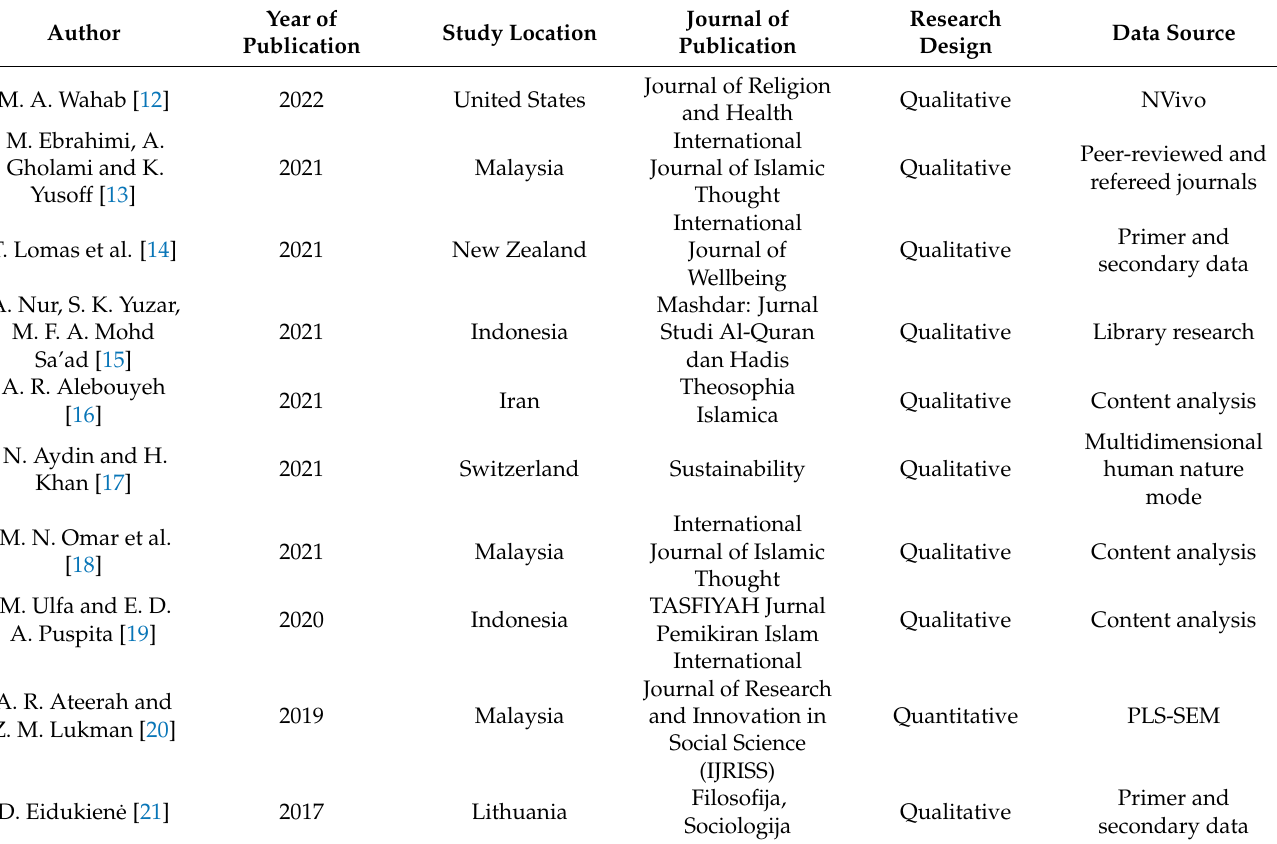
Table 3. General information of articles and data sources from selected